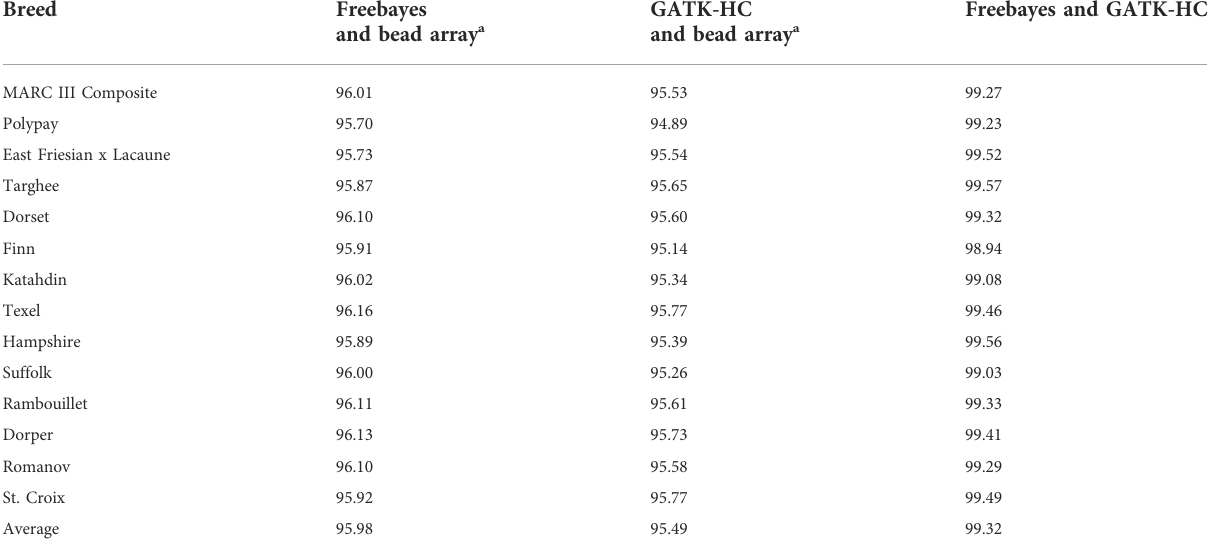
GATK-HC and bead array a